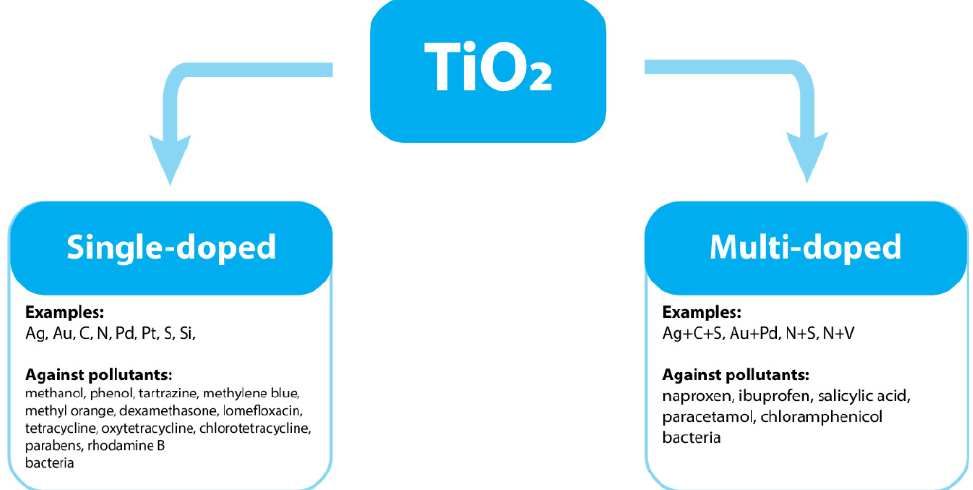
Figure 7. Possible modifications of TiO 2 with other atoms and substances that are decomposed due to the catalytic properties of obtained composites.